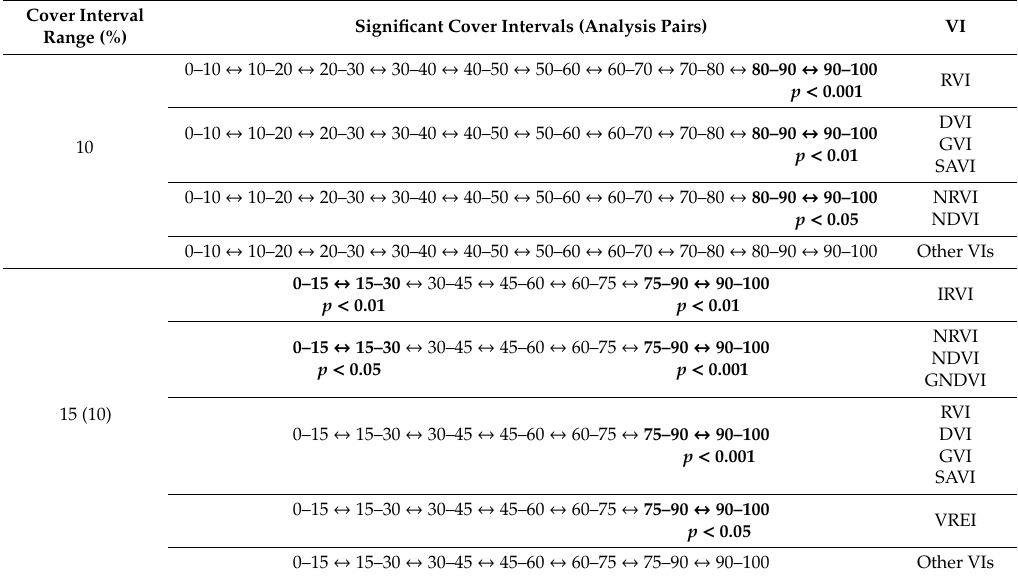
Table 3. Tukey’s HSD test of reflectance values for VIs and ground-truth VGC at different intervals. The table expresses in a range of increasing coverage interval (from 10% to 30%) the separability between coverage intervals for each VI applied. The coverage interval ranges within the parentheses correspond to VGC values greater than 90% because the entire series could not be divided into regular intervals. Bold letters indicate that there is statistically significant separability in coverage intervals, accompanied by the level of significance ( p ). Cover Interval Range (%)